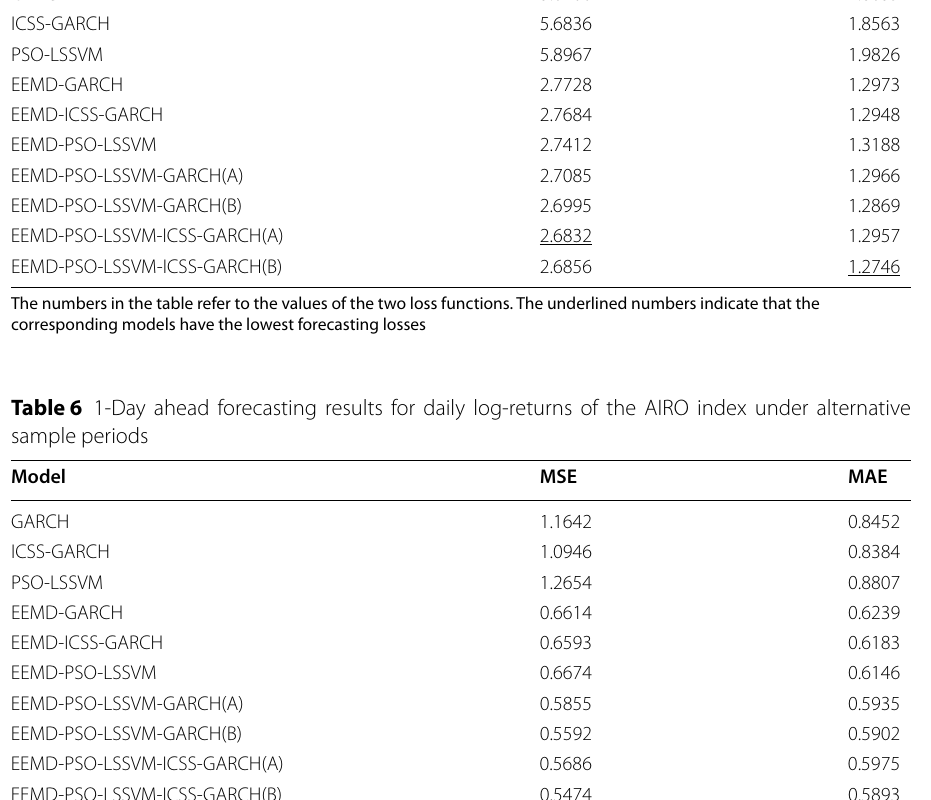
Table 5 1‑Week ahead forecasting results for weekly log‑returns of the AIRO index